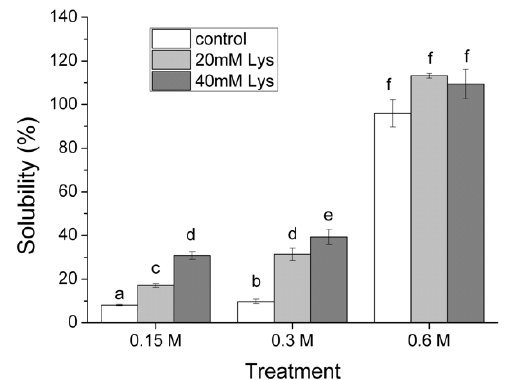
Figure 1. The effects of Lys on the solubility of MFP at different ionic strengths. Columns with different letters indicate significant differences at the level of p < 0.05. 0.15 M, treatment with ionic strength of 0.15 M NaCl; 0.3 M, treatment with ionic strength of 0.3 M NaCl; 0.6 M, treatment with ionic strength of 0.6 M NaCl; control, treatment without Lys addition; 20 mM Lys, treatment with 20 mM Lys; 40 mM Lys, treatment with 40 mM